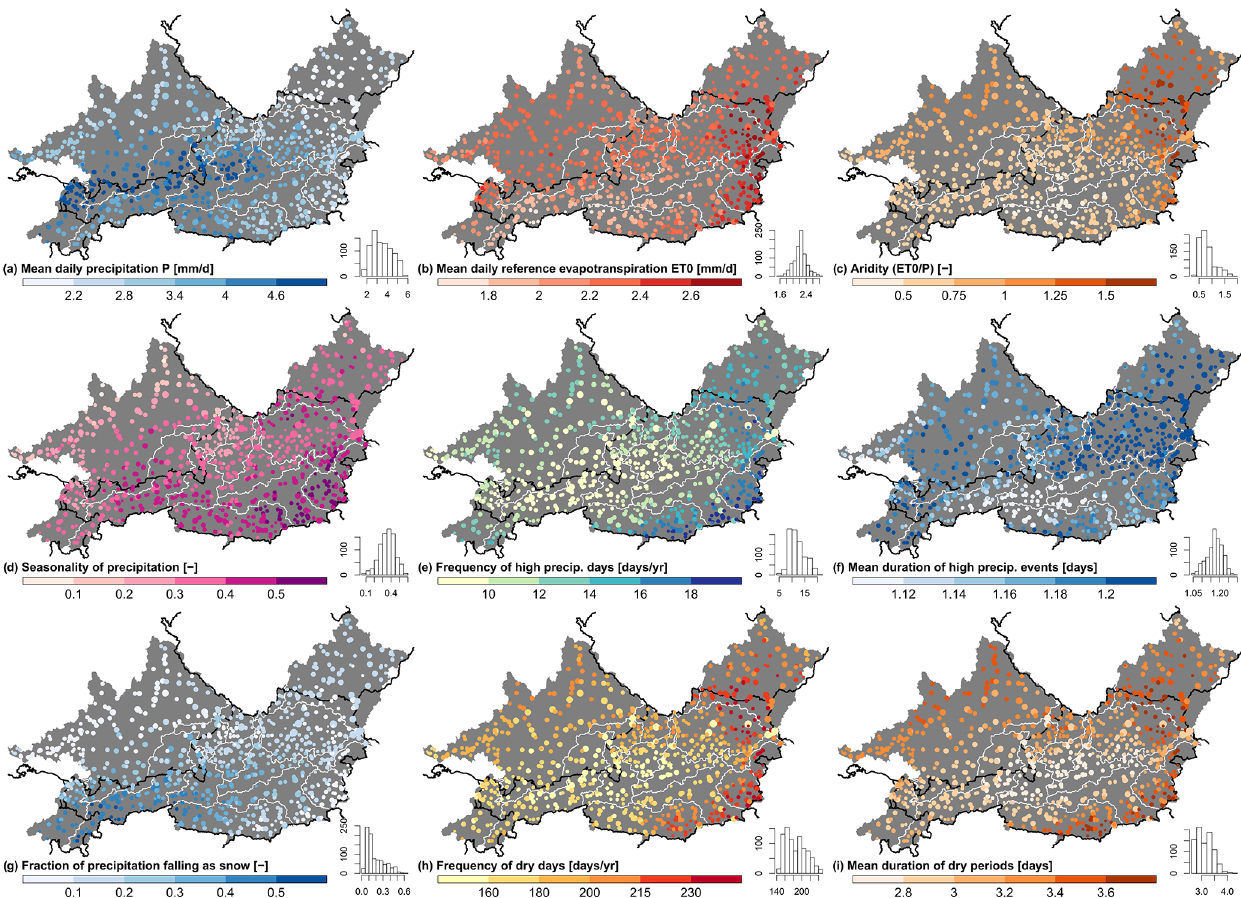
Figure 6. Spatial distribution of a selection of climate indices representing the characteristics of the entire topographic catchment (basin delineation A, Fig. 2a). The histograms indicate the number of basins (out of 859) in each category. The size of the circles is proportional to the catchment area. © EuroGeographics for the administrative